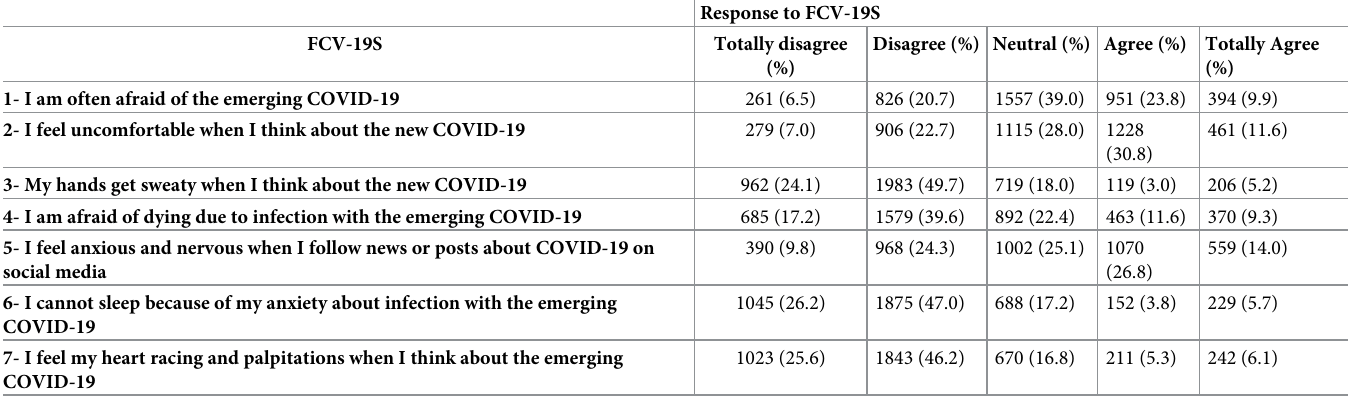
Table 2. Participants response to